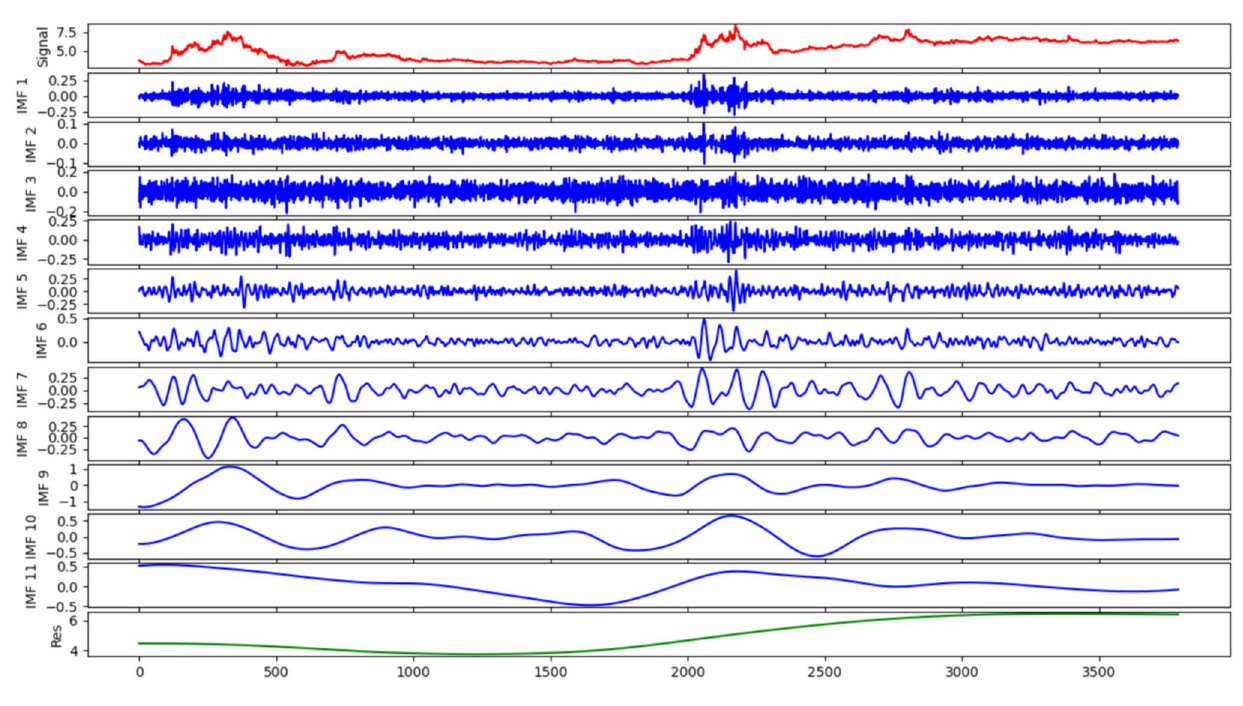
Fig. 7 The decomposition results of CEEMD for SH601988